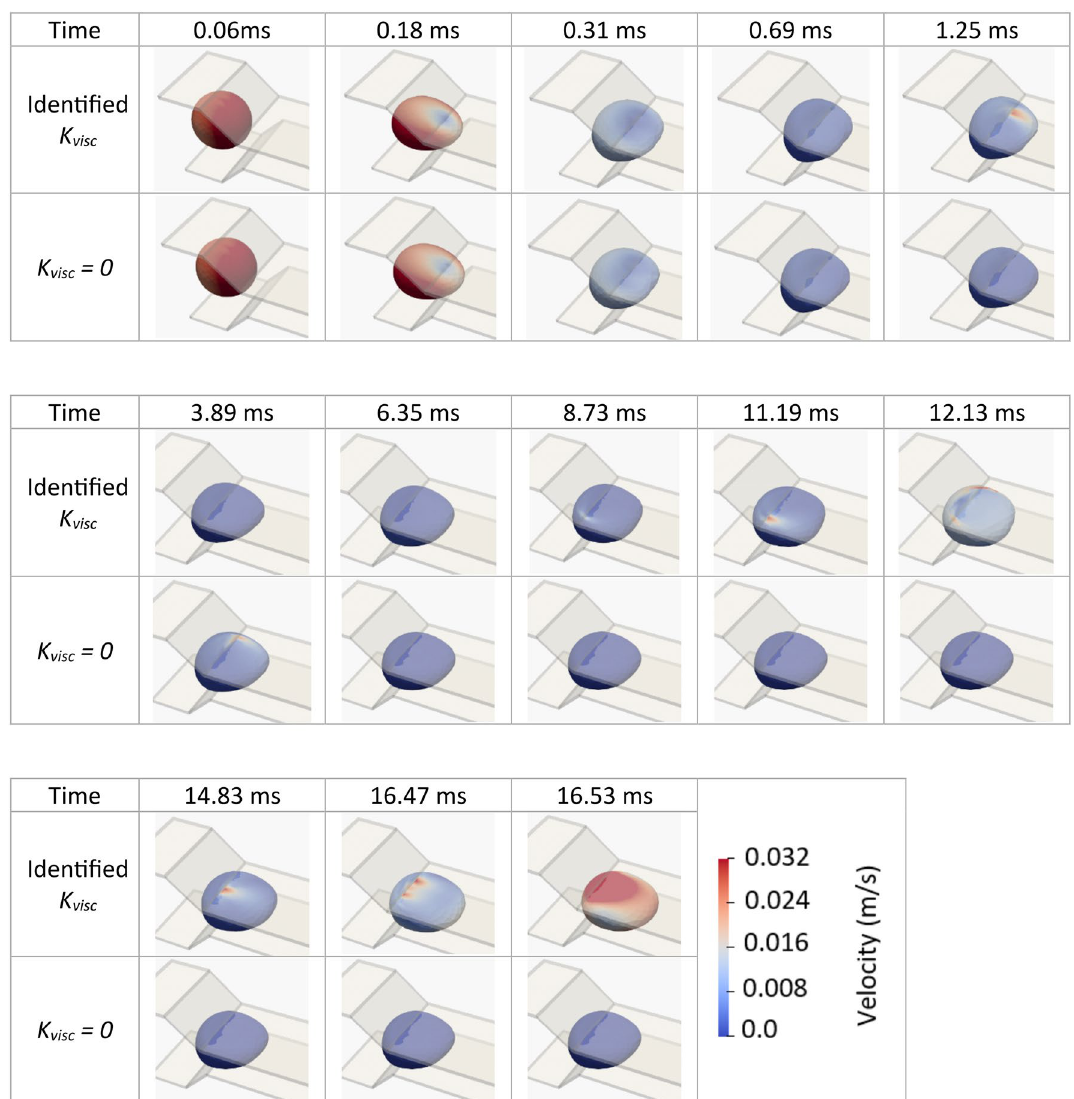
Figure 6. Effects of the viscosity of cell membrane on the 3-D motion and deformation of a lung cancer cell in a microfluidic constriction at the flow rate of at 22.8 µL/h. Neglecting the viscosity caused the cell to get stuck at the constriction entrance after the 6.53 ms while the cell with correctly identified viscosity underwent drastic deformations until it successfully entered the constriction at 16.53